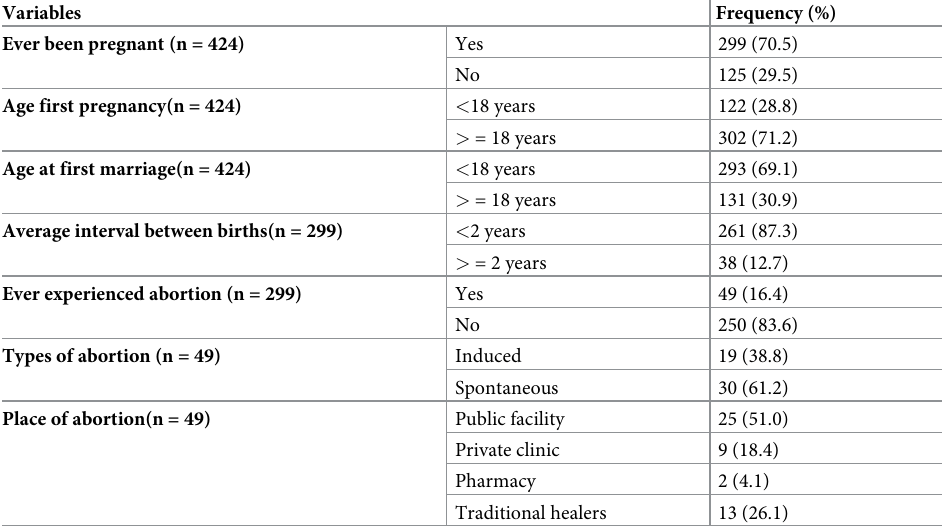
Table 4. Reproductive characteristics of currently pregnant married women youths of Kiremu district, Oromia, Ethiopia,